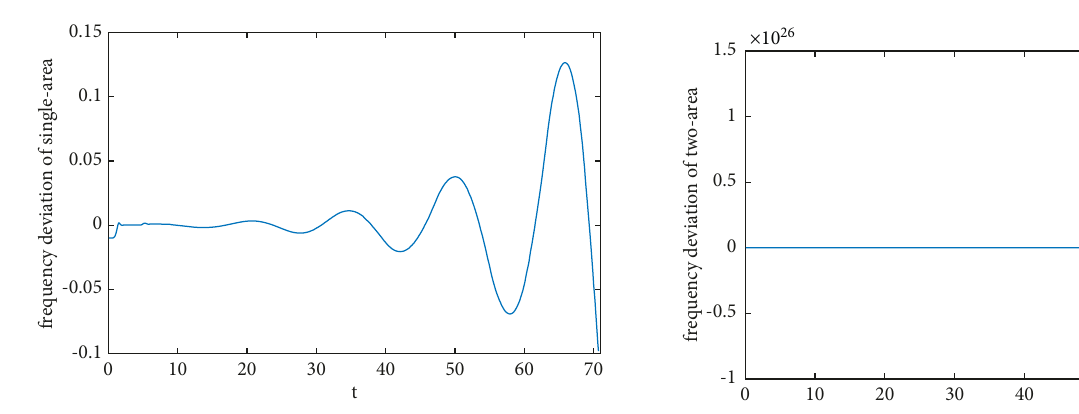
Figure 10: Frequency responses with h � 7 of single-area.